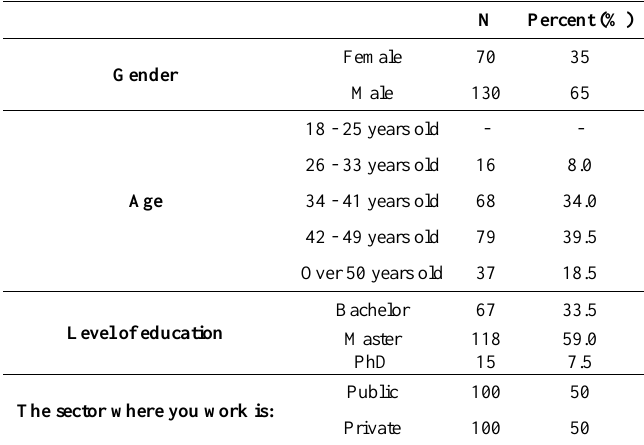
Table 1. Respondent Characteristics (N=200)